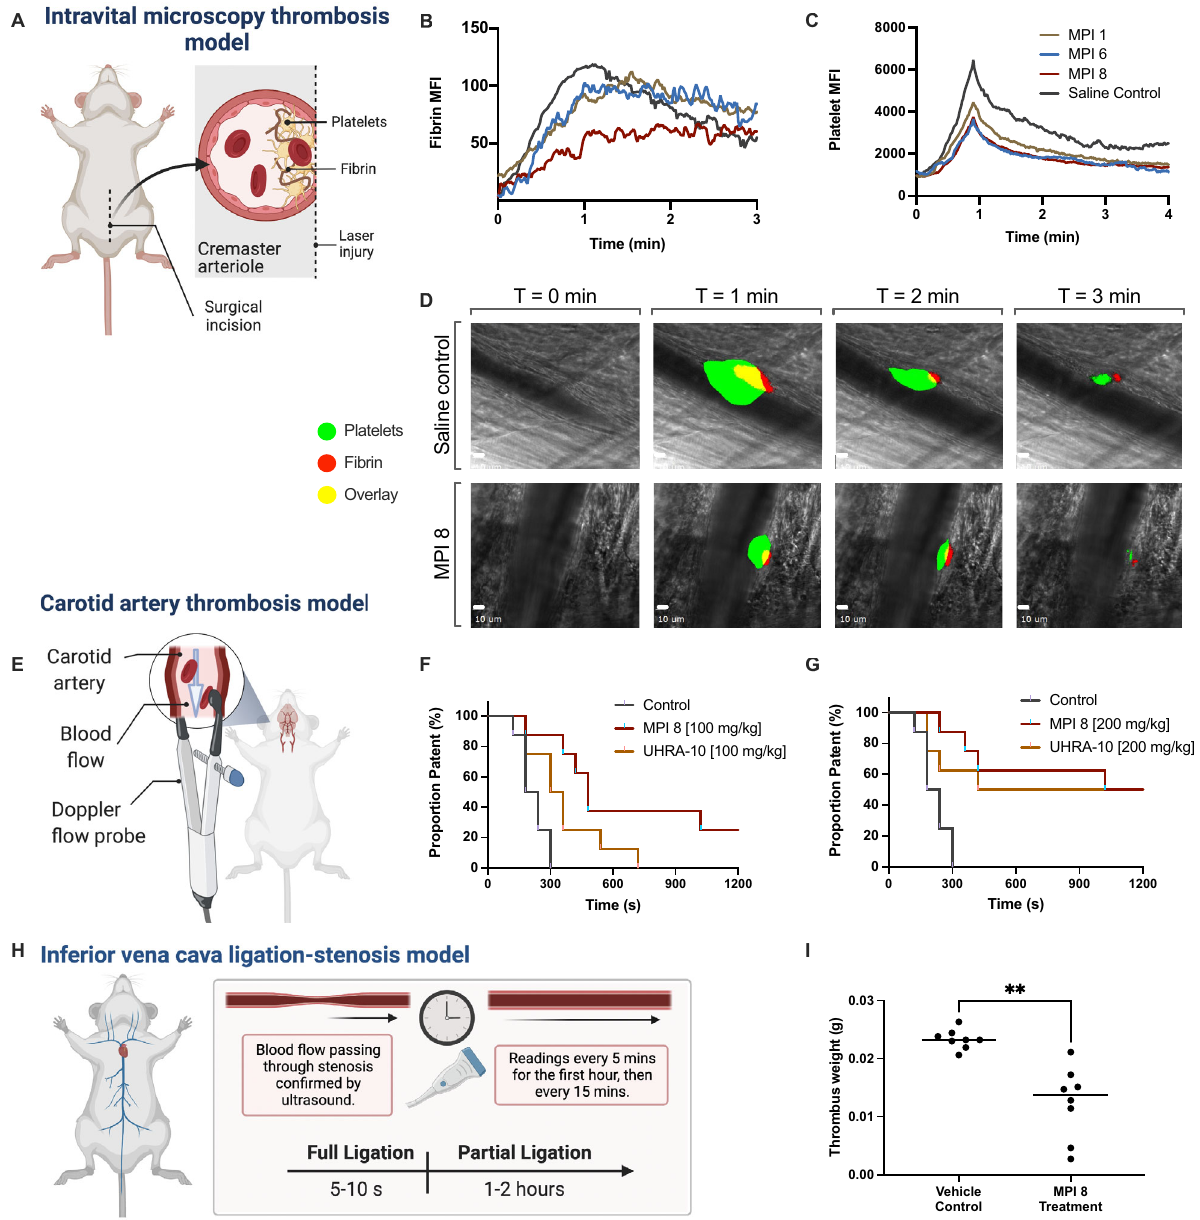
Fig. 5 | MPI 8 exhibits antithrombotic properties in mice. A – D MPI 8 reduced fi brin clot formation and platelet accumulation in mouse cremaster arteriole thrombosismodel. A Schematicrepresentationofthethrombosismodel:Platelets and fi brin are tagged with fl uorescent antibodies and can be visualized as they accumulate at the site of injury upon laser-induced injury. B Median fl uorescence intensity representative of fi brin accumulation over time. C Median fl uorescence intensity representative of platelet accumulation over time. D Representative images of thrombus growth at 0 – 3mins in mice which were treated with saline or MPI 8. All results shown are mean+/ − SD of n =3 mice. E – G MPI 8 delays time to occlusion in carotid artery thrombosis model. E Schematic representation of the thrombosis model. Artery patency was monitored by Doppler fl ow probe. Injury was induced by topical application of FeCl 3 and patency is plotted versus time, comparing the saline control and MPI 8. UHRA-10 was used as a control. F At